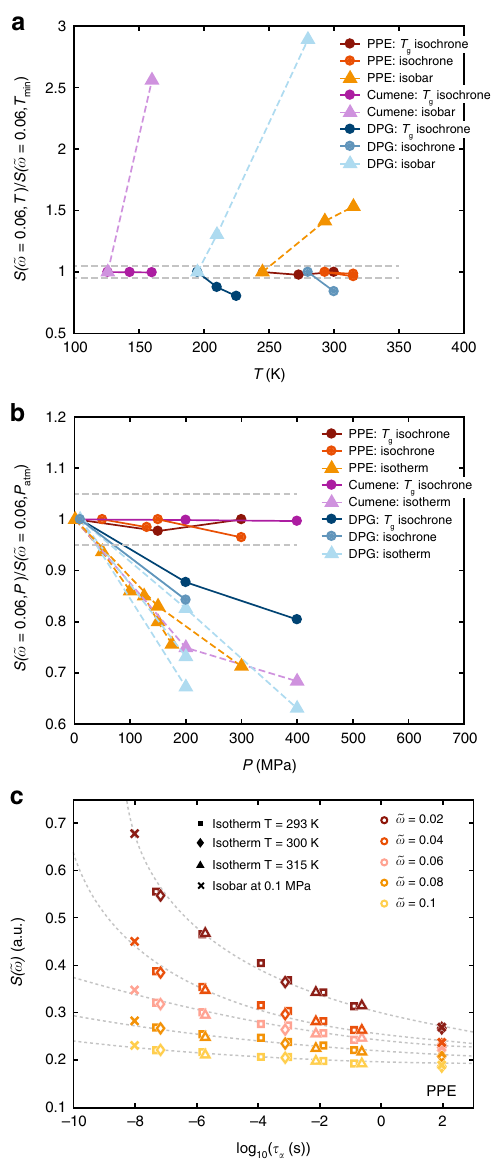
Fig. 3 Comparison of state points via the inelastic intensity at fi xed reduced energies. a , b Inelastic intensity at fi xed reduced energy ~ ω ¼ 0 : 06 ð Þ along isochrones, isotherms and isobars from the spectra in Fig. 2 plotted a as a function of temperature normalized to value at lowest temperature, b as a function of pressure normalized to the value at ambient pressure. c Inelastic intensity for fi xed reduced energies for PPE as a function of τ α ( T , P ) for two isotherms, 293 K (squares), 300 K (diamonds), 315 K (triangles) and an isobar (crosses) for the reduced energies ~ ω = 0.02, 0.04, 0.06, 0.08, 0.1 covering more than ten orders of magnitude in relaxation time. All lines